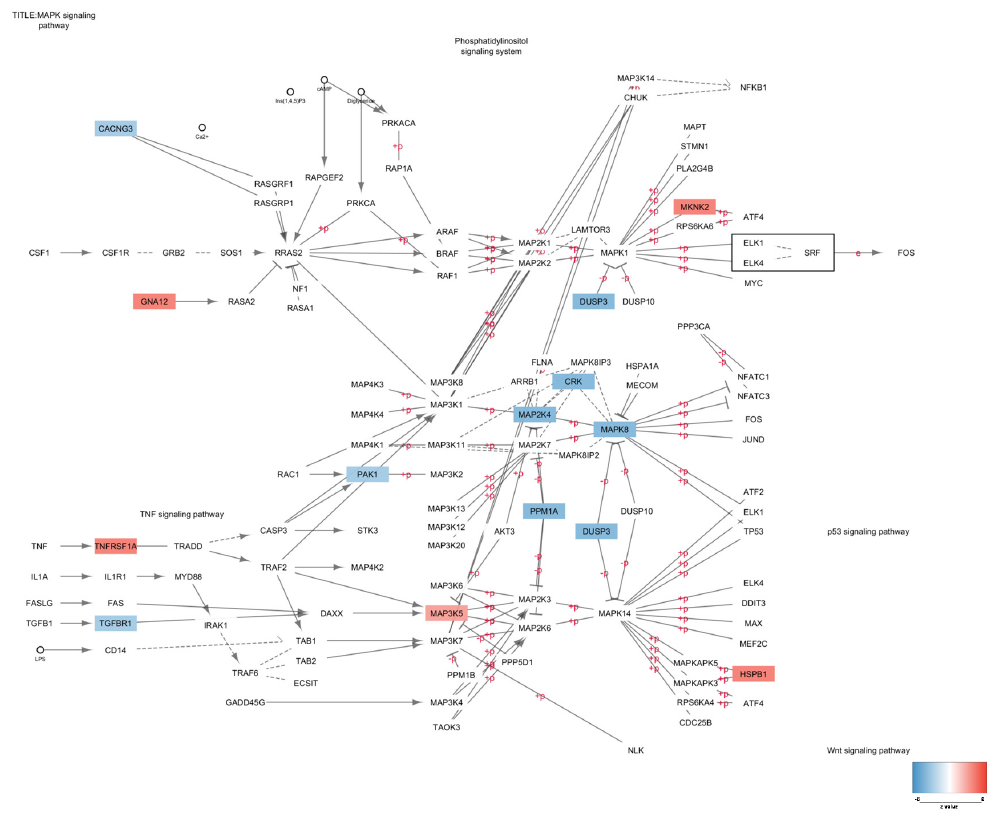
Figure 2. MAPK signaling pathway with nodes color-coded based on the z-value obtained from the meta-analysis of the GSE53987, GSE12649 and GSE21138 datasets.